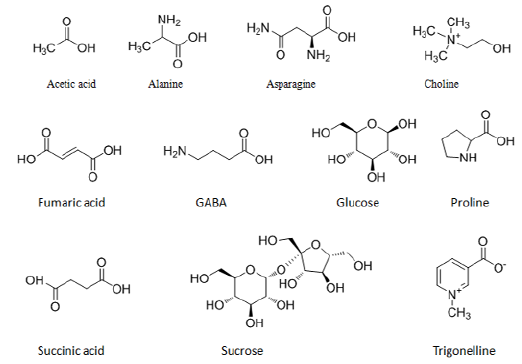
Figure 2. Chemical structures of 11 metabolites from mulberry leaf extracts. Table 1. Proton NMR spectroscopic data for 11 metabolites in D 2 O.